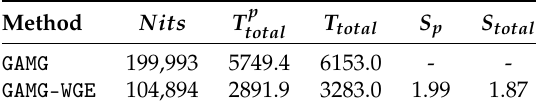
Table 4. The test result of 3D blended-wing-body airfoil †